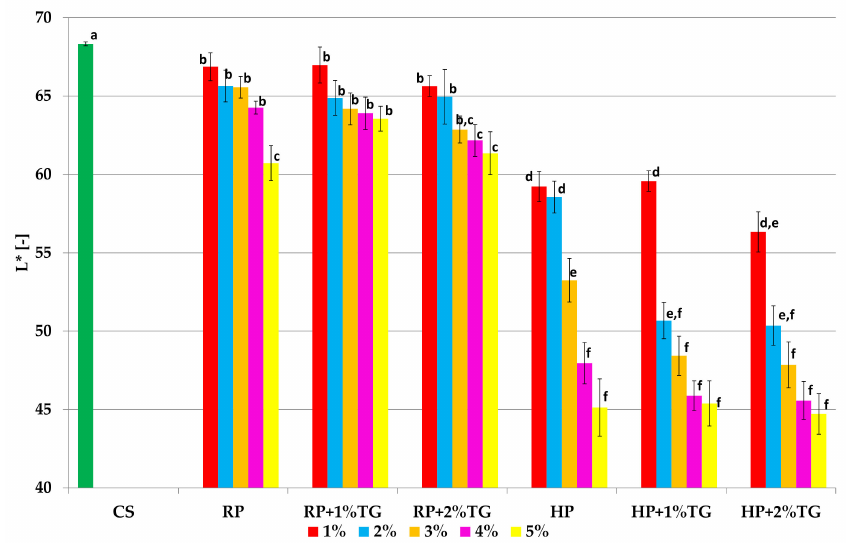
Figure 3. Average values of the L * parameter of instant noodles with the addition of rice protein, hemp protein and TGase (CS—control sample, RP—rice protein, RP+1%TG—rice protein with 1% TGase, RP+2%TG—rice protein with 2% TGase, HP—hemp protein, HP+1%TG—hemp protein with 1% TGase, HP+2%TG—hemp protein with 2% TGase). Columns correspond to various additions of rice protein. Mean values denoted by different letters ( a – f ) represent statistically significant differences between variables ( p <